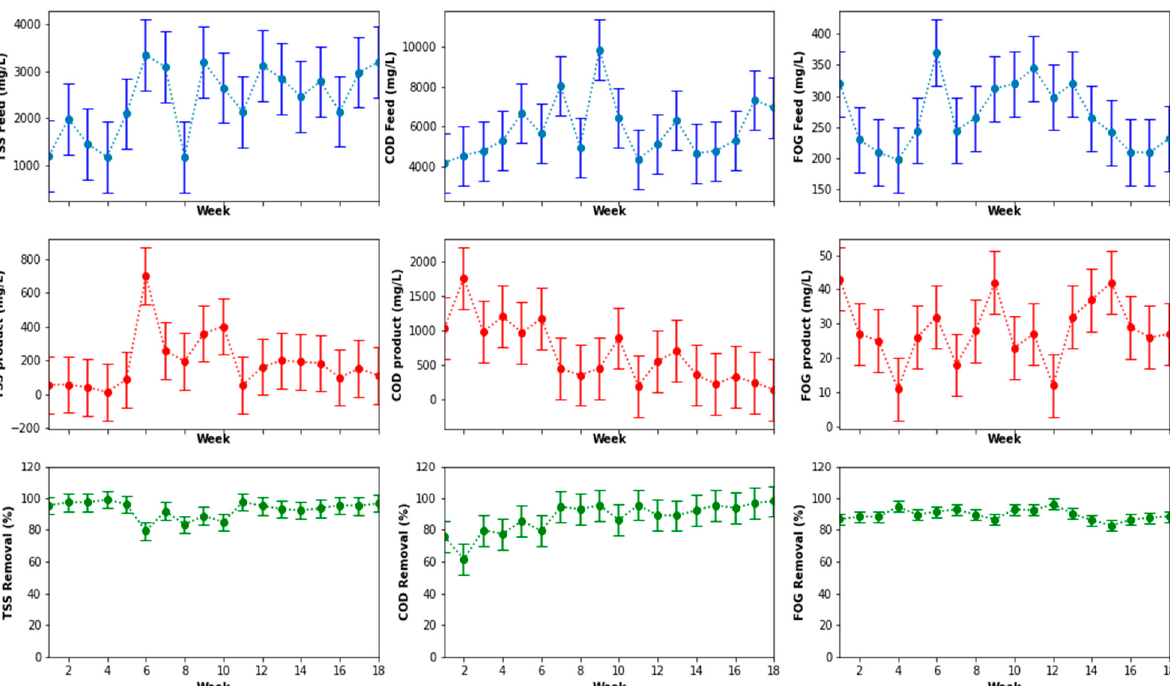
Figure 8. Performance of the DEGBR before outliers replacement.